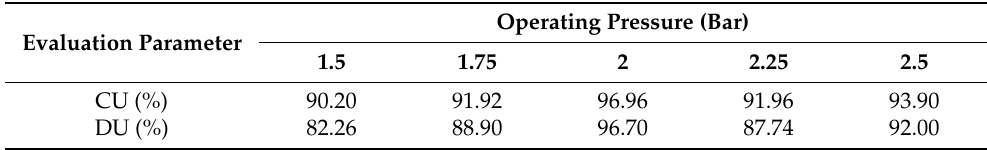
Table 3. The hydraulic evaluation parameters of foggers at different operating pressures. Mean values are given